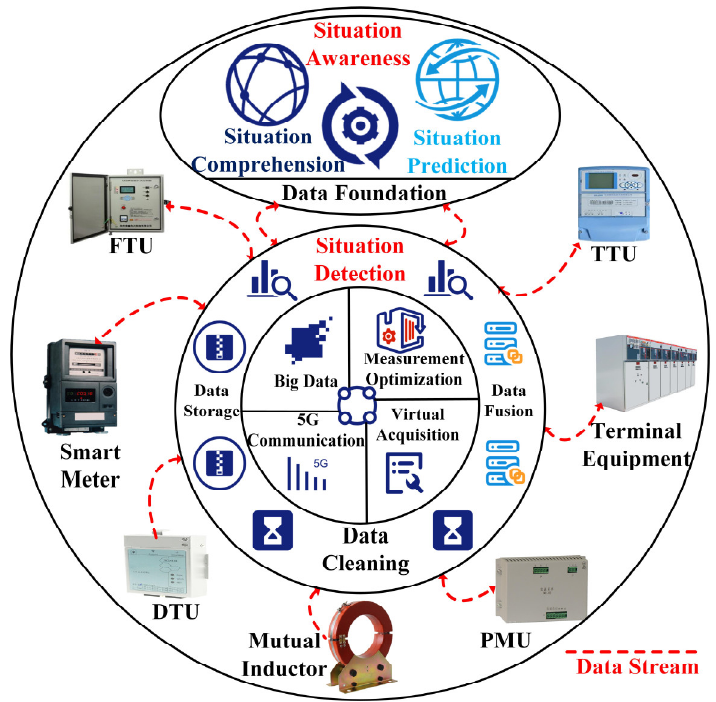
Figure 2. The implementation framework of situation detection.